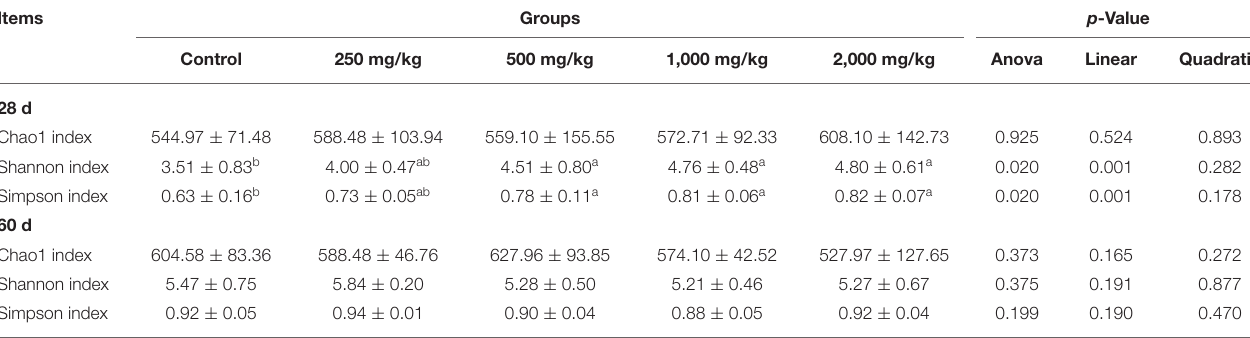
TABLE 7 | Effect of dietary Galla chinensis extract (GCE) supplementation at different levels on alpha diversity indexes of cecal microbiota in broilers. Items Groups p -Value